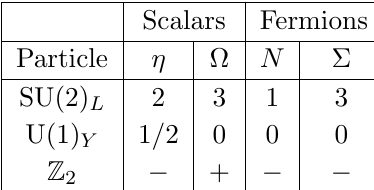
Table 1 . New particle content and charges under the SU(2) L